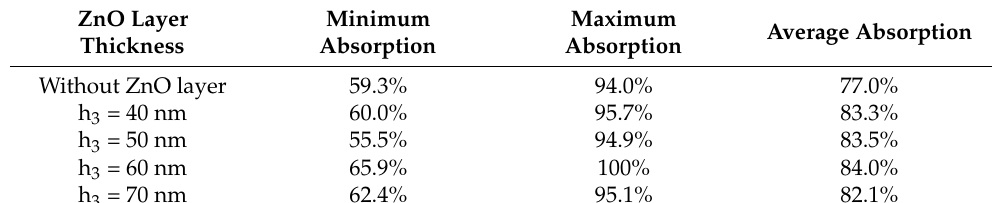
Table 3. Absorption for different dielectric substrates.